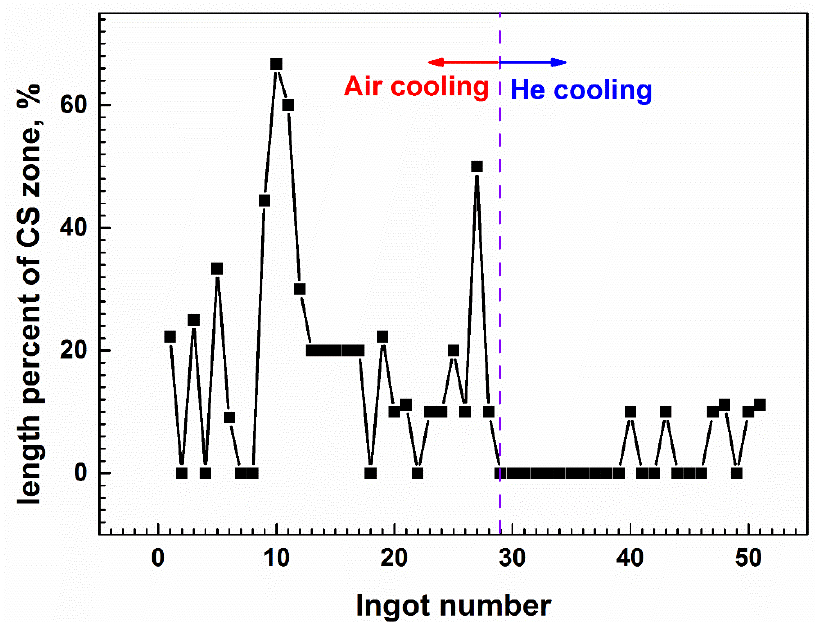
Figure 6. Statistics of the length percentage of the CS zone in the ingot body in Air-and He-cooled ingots.